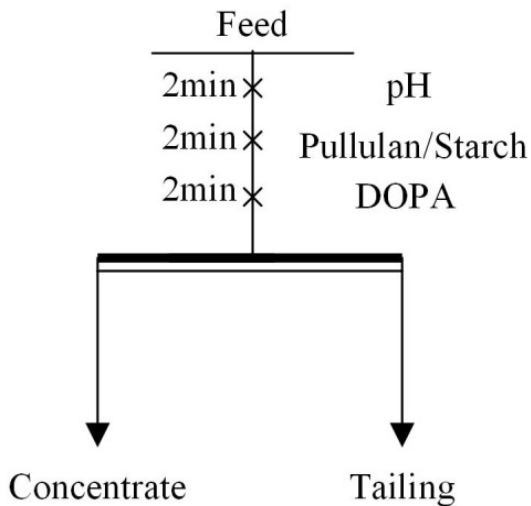
Figure 1. Flowsheet of flotation experiments.